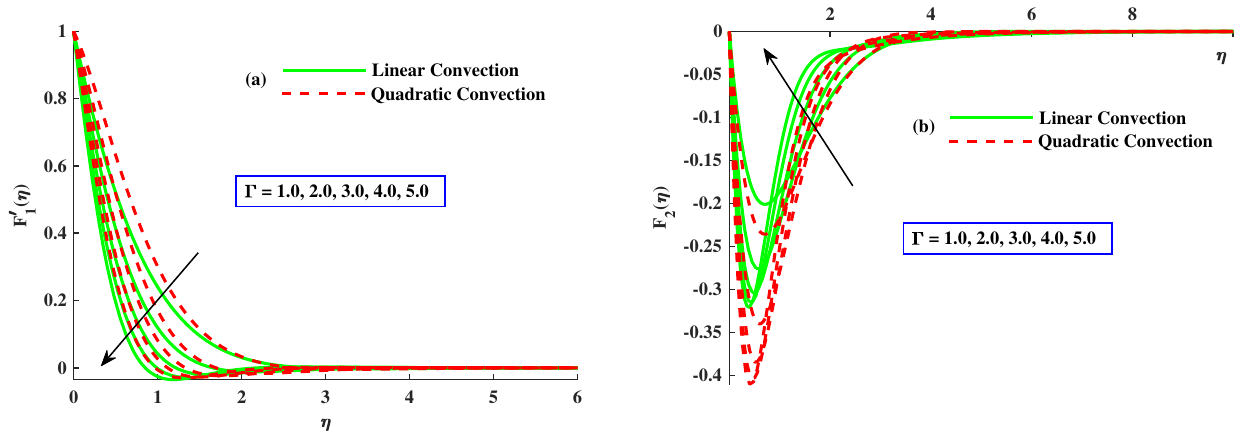
Figure 2. The influence of Γ on the F 1 (cid:48) ( η ) and F 2 ( η ) . The influence of mixed convection parameter λ 1 on velocity F (cid:48) distribution profiles, with and without quadratic convection, is shown in Figure